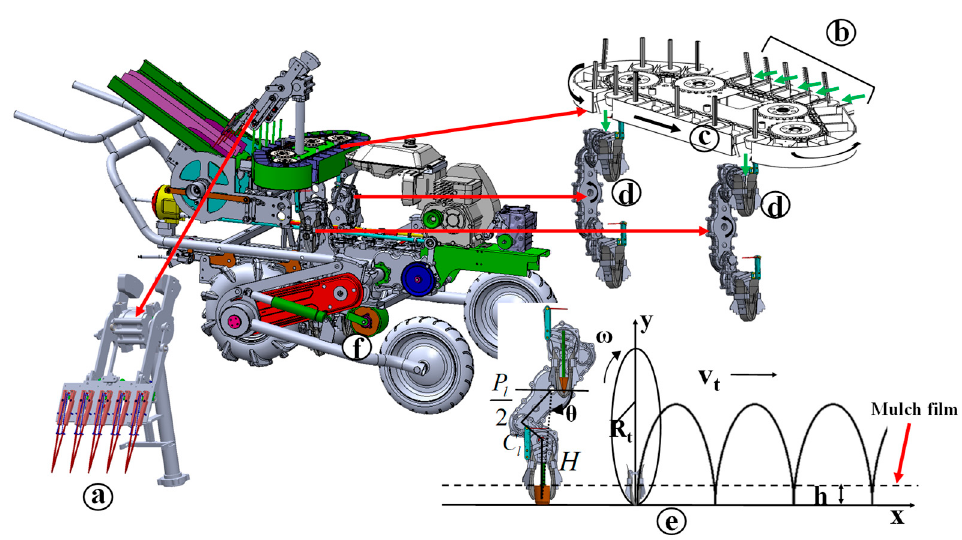
Figure 1. Structure of the pepper transplanter under development: ( a ) seedling picking manipulator, ( b ) seedling supply, ( c ) conveying unit, ( d ) dibbling mechanism, ( e ) mathematical model of dibbling operations, and ( f ) soil-compacting device.